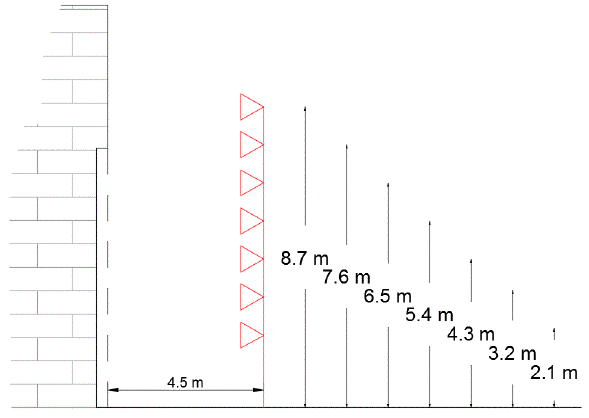
Figure 9. Camera positions at different heights.